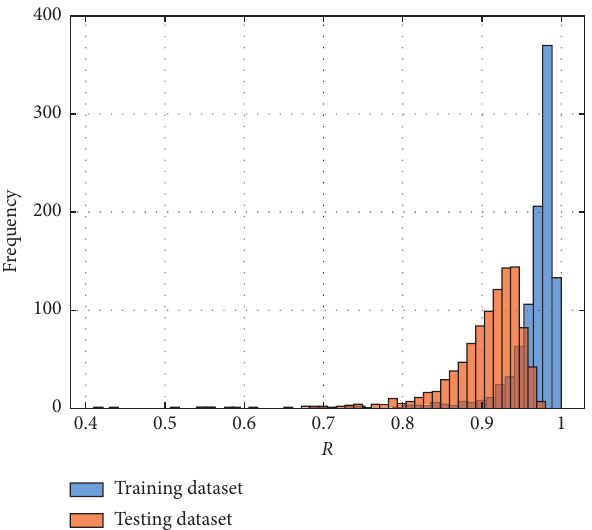
Figure 2: Histogram of R values over 1000 simulations for the training and testing parts.